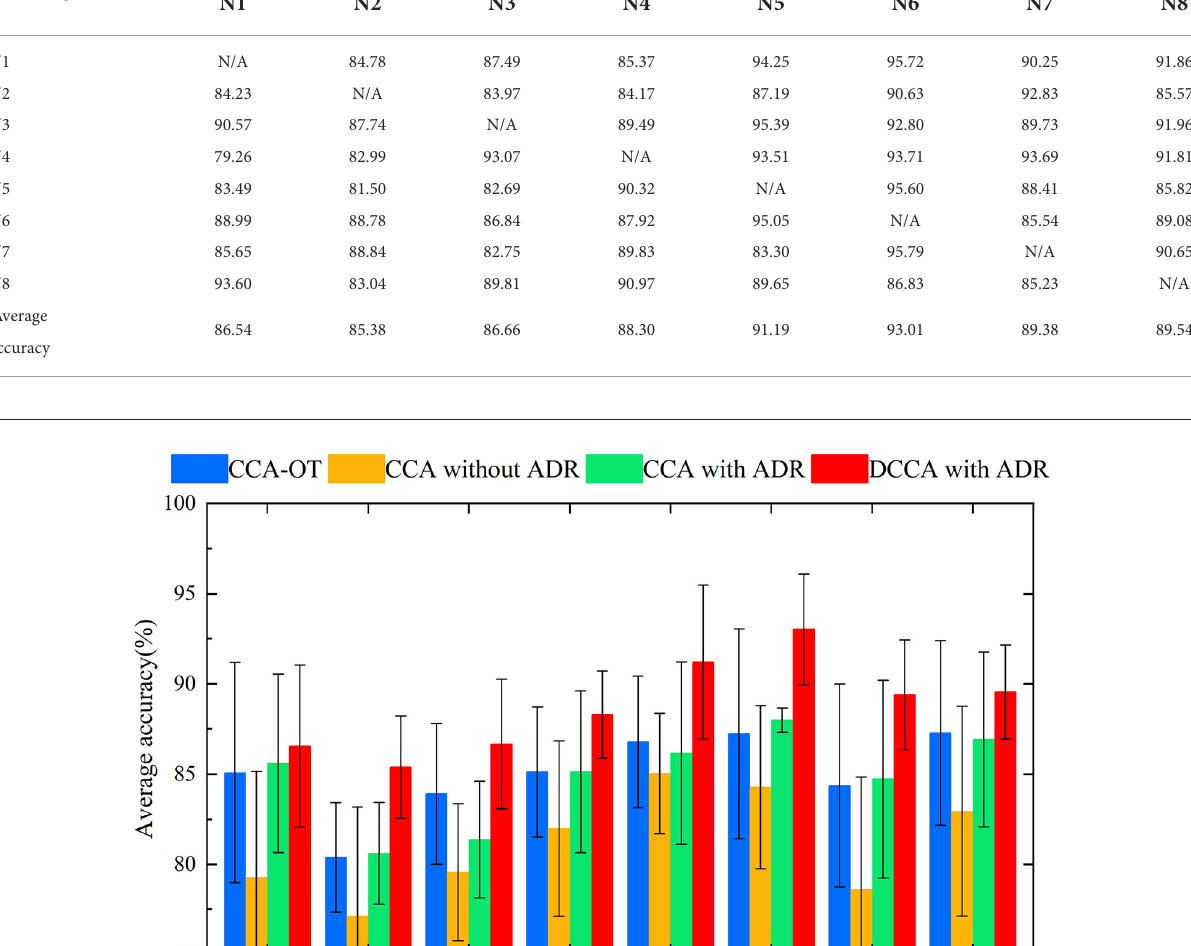
TABLE 8 Experimental results for user-independent DCCA-with-ADR framework (the sEMG data of all test users were reduced randomly by two channels). Training user